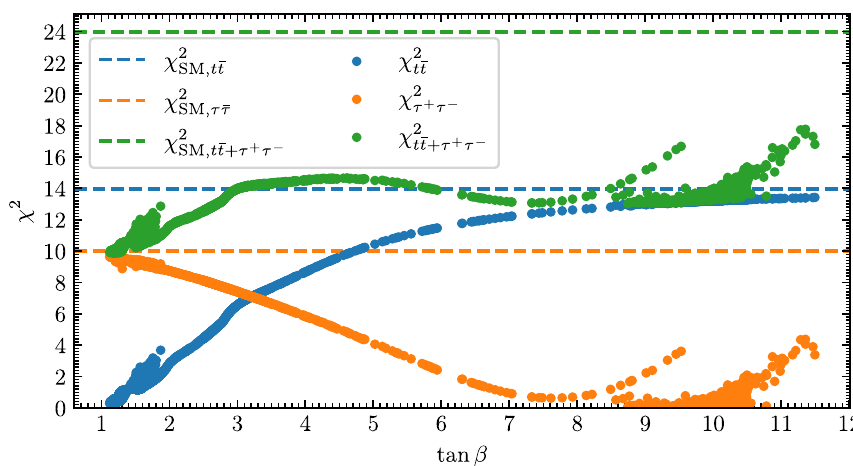
cross sections of A → τ + τ − for the gg production mode on the hori- zontal axis and the b ¯ b production mode on the vertical axis. The colors of the points indicate the value of tan β . The dark blue and the yellow lines indicate the 1 σ and 2 σ ellipse of χ 2 τ + τ − [7], respectively. In both plots the best-fit point, labelled as min (χ 2 ) , is indicated with a magenta star. The point with the smallest value of χ 2 τ + τ − + χ 2 ) , is indicated with a cyan star min (χ 2 τ + τ − + χ 2 125